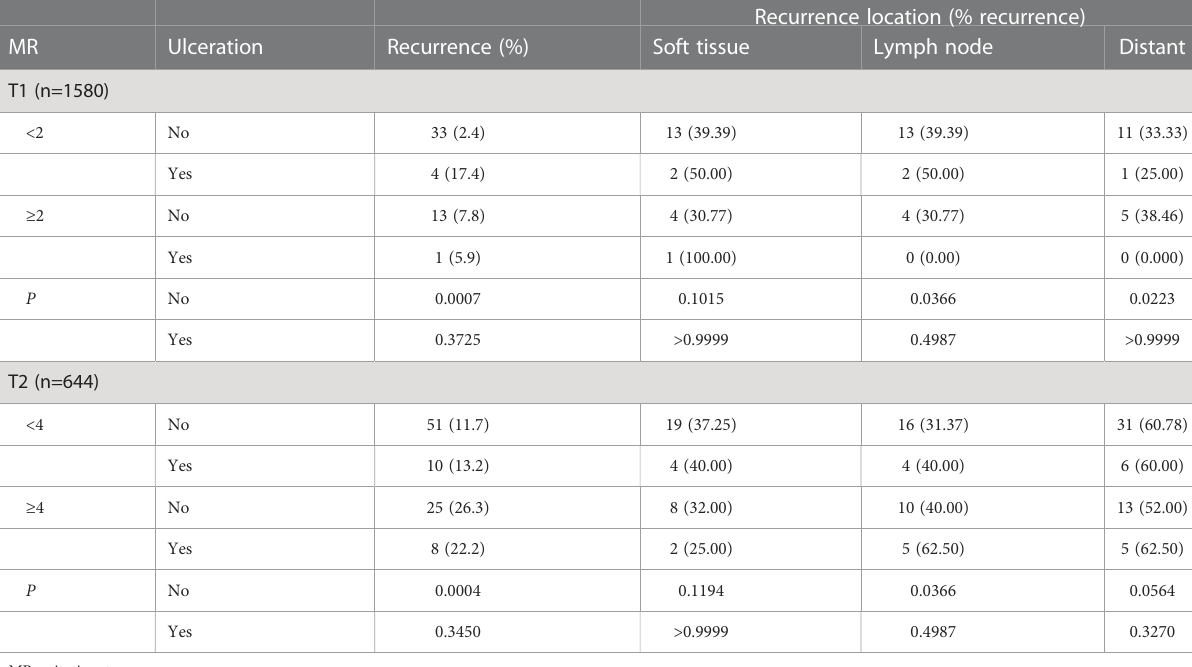
TABLE 5 Recurrence location among patients with T1 and T2 tumors separated by mitotic rate and ulceration.